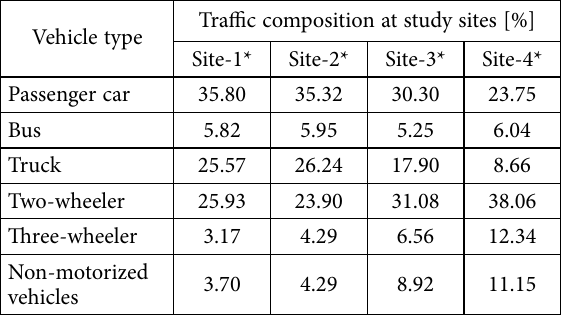
Fig. 4. A view of extraction of entry and exit time of vehicles using Avidemux 2.5 Table 2. Observed traffic composition at study sites